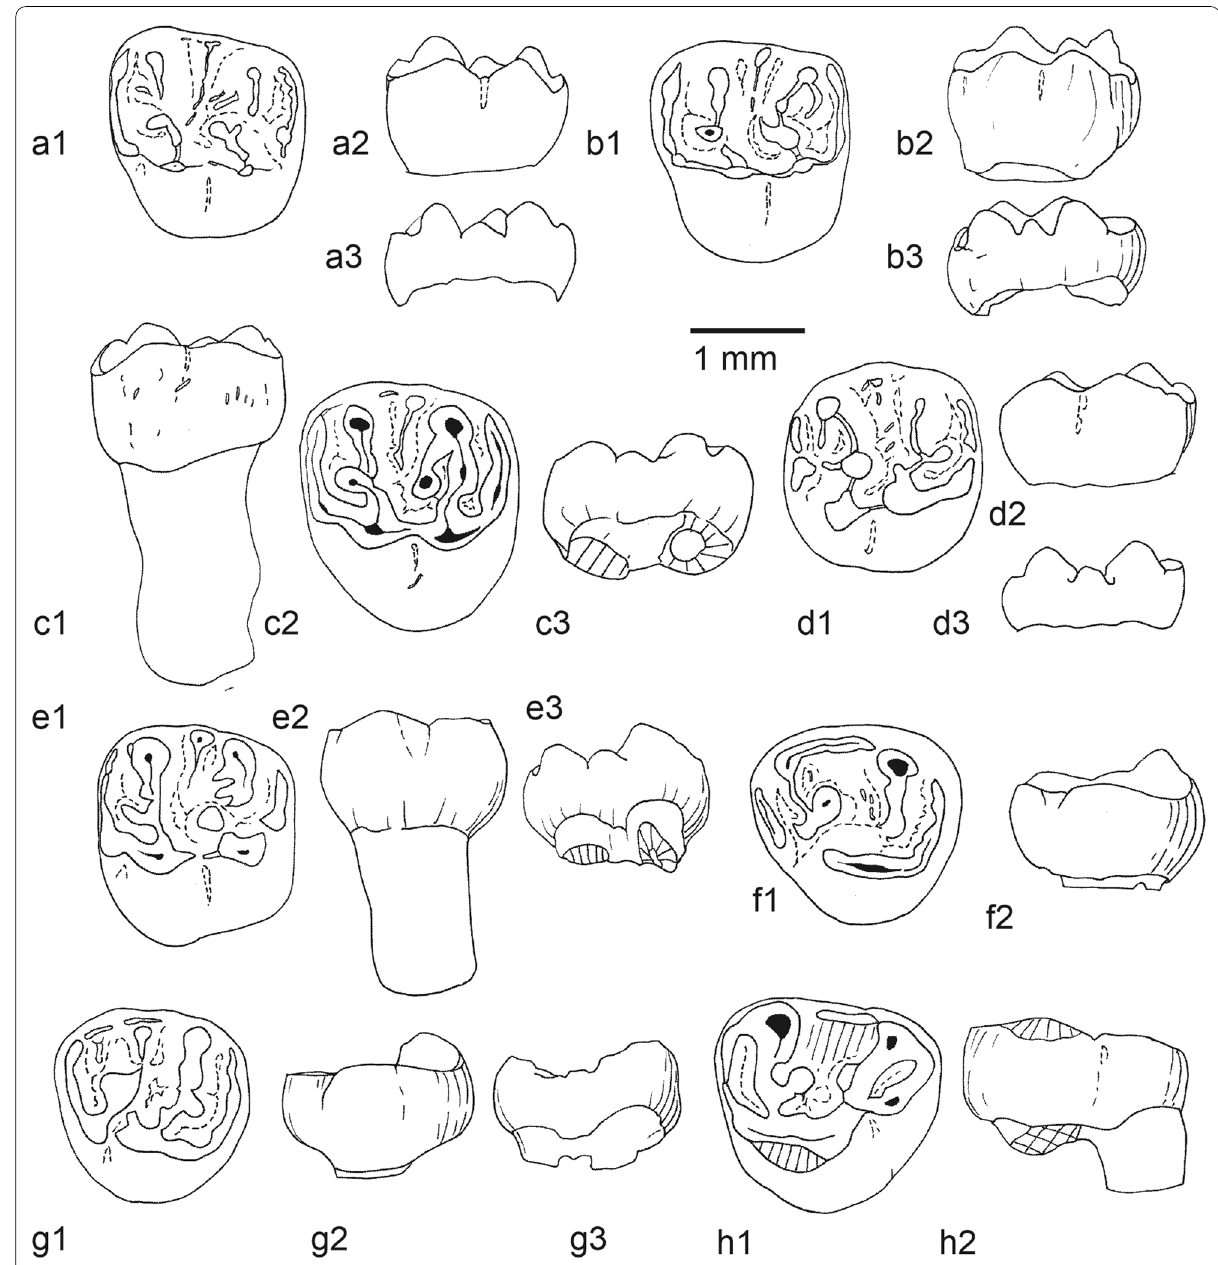
Fig. 16 Upper teeth of Protadelomys lugdunensis Hartenberger, 1969 from Lissieu (Rhône). a LIS 1, left M1 or 2; a1, occlusal view; a2, lingual aspect; a3, buccal aspect. b LIS 3, left M1 or M2; b1, occlusal view; b2, lingual aspect; b3, buccal aspect. c : LIS 28, left M2; c1, occlusal view; c2: lingual aspect; c3: buccal aspect. d LIS 2, right M2; d1, occlusal view; d2: lingual aspect; d3: buccal aspect. e LIS 8, left M2; e1, occlusal view; e2: lingual aspect; e3: buccal aspect. f LIS 15, right M3; f1, occlusal view; f2: lingual aspect. g LIS 19, right M3; g1, occlusal view; g2: lingual aspect; g3: buccal aspect. h LIS 17, left M3; h1, occlusal view; h2: lingual aspect. Scale bar: 1